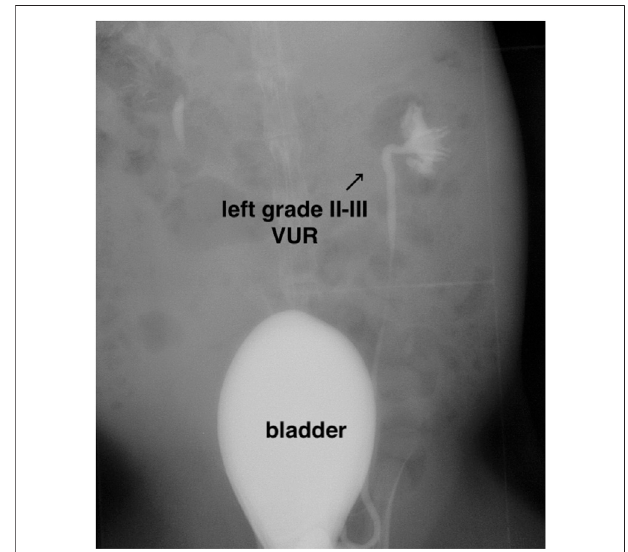
Representative VCUG image of the rabbit with II – III VUR grade in the left intravesical